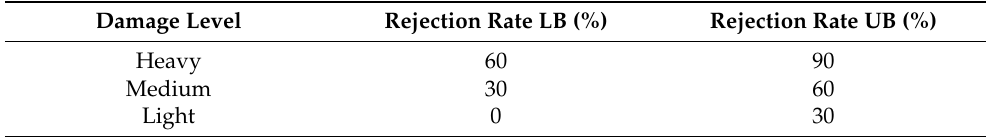
Table 1. Damage level